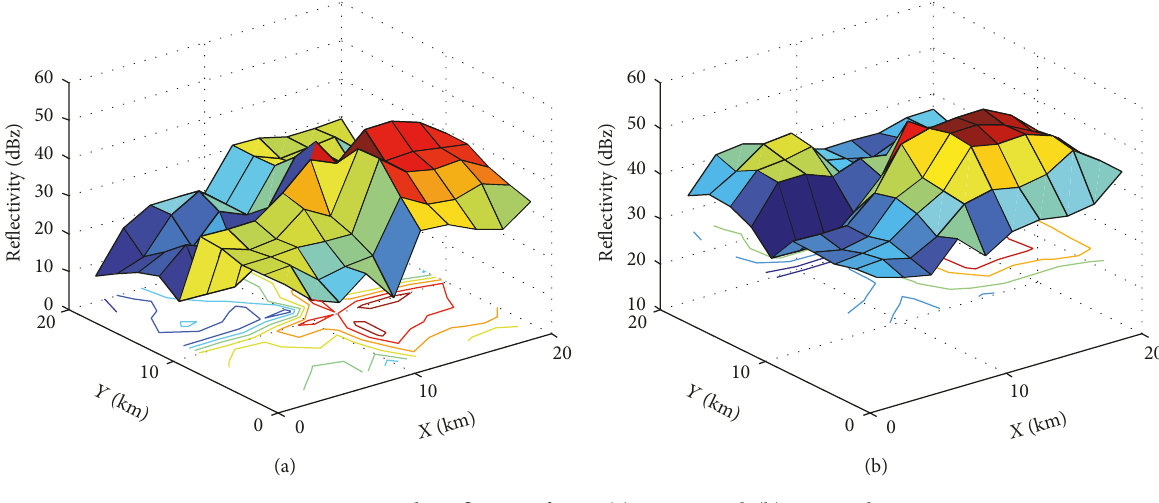
Figure 8: Radar reflectivity factor: (a) uncorrected; (b) corrected.